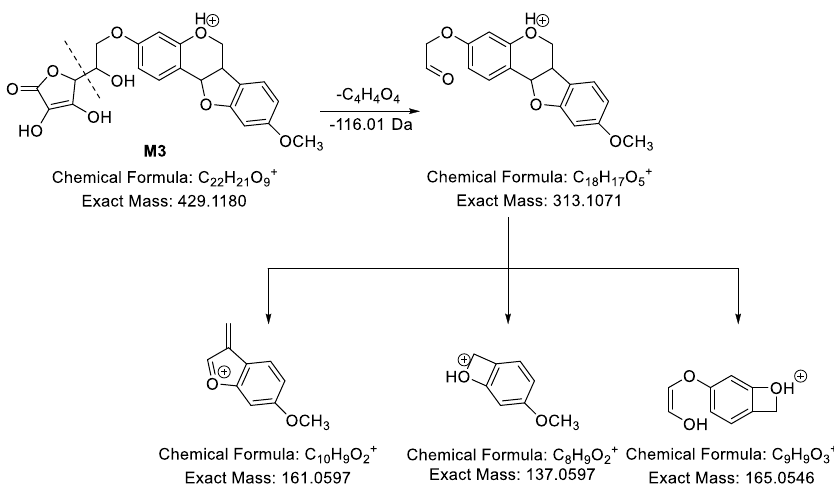
Figure 5. The proposed fragmentation pathways of M3 in ESI+ mode.